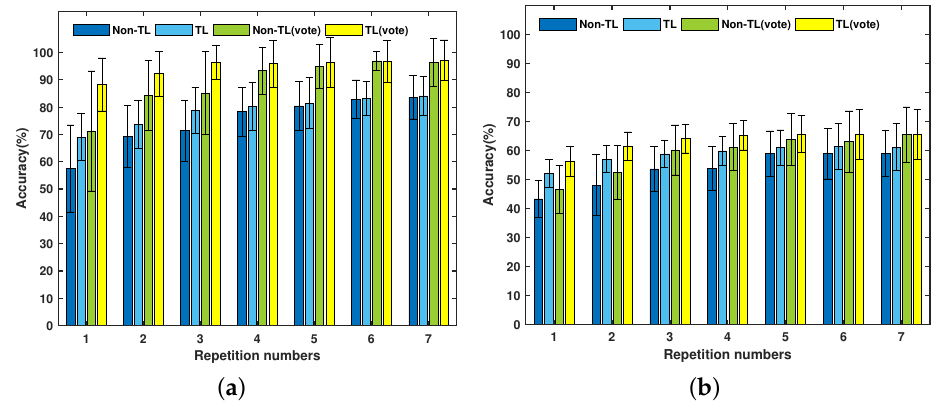
Figure 7. The comparison of the accuracy of instantaneous recognition and major voted recognition of the target network under the TL strategy and non-TL strategy for new gesture recognition: ( a ) DB-a and ( b ) Exercise